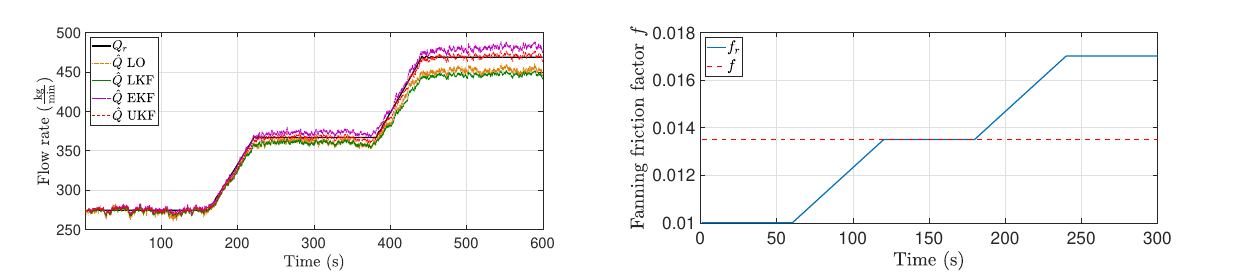
Figure 4: Estimated flow rates ( ˆ Q ) from different esti- mators against the true flow rate ( Q r ). ‘LO’: linear observer, ‘LKF’: linear (standard) Kalman filter, ‘EKF’: extended Kalman fil- ter and ‘UKF’: unscented Kalman filter